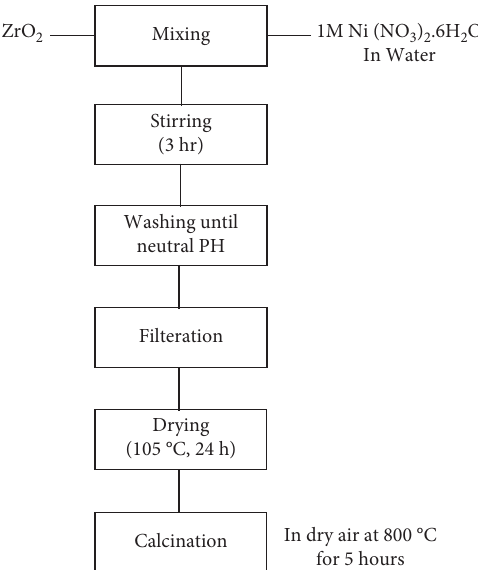
Figure 1: Wet impregnation method